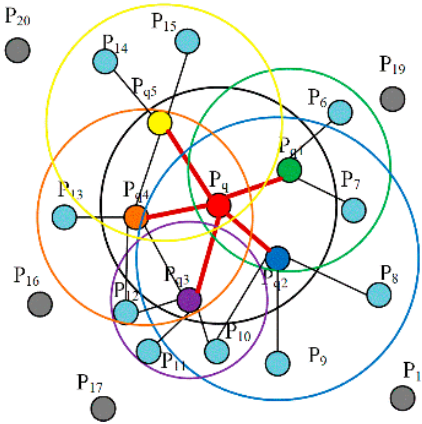
Figure 4. Neighborhood influence area of the point P q for ACFPFH. Step 2: The point pairs p , p are generated based on the query point P q and the s t neighborhood points P qj . Estimate their corresponding normal n s and n t . The relative relationship between the point pairs p , p is obtained by establishing a local frame, as s t shown in Figure 5.